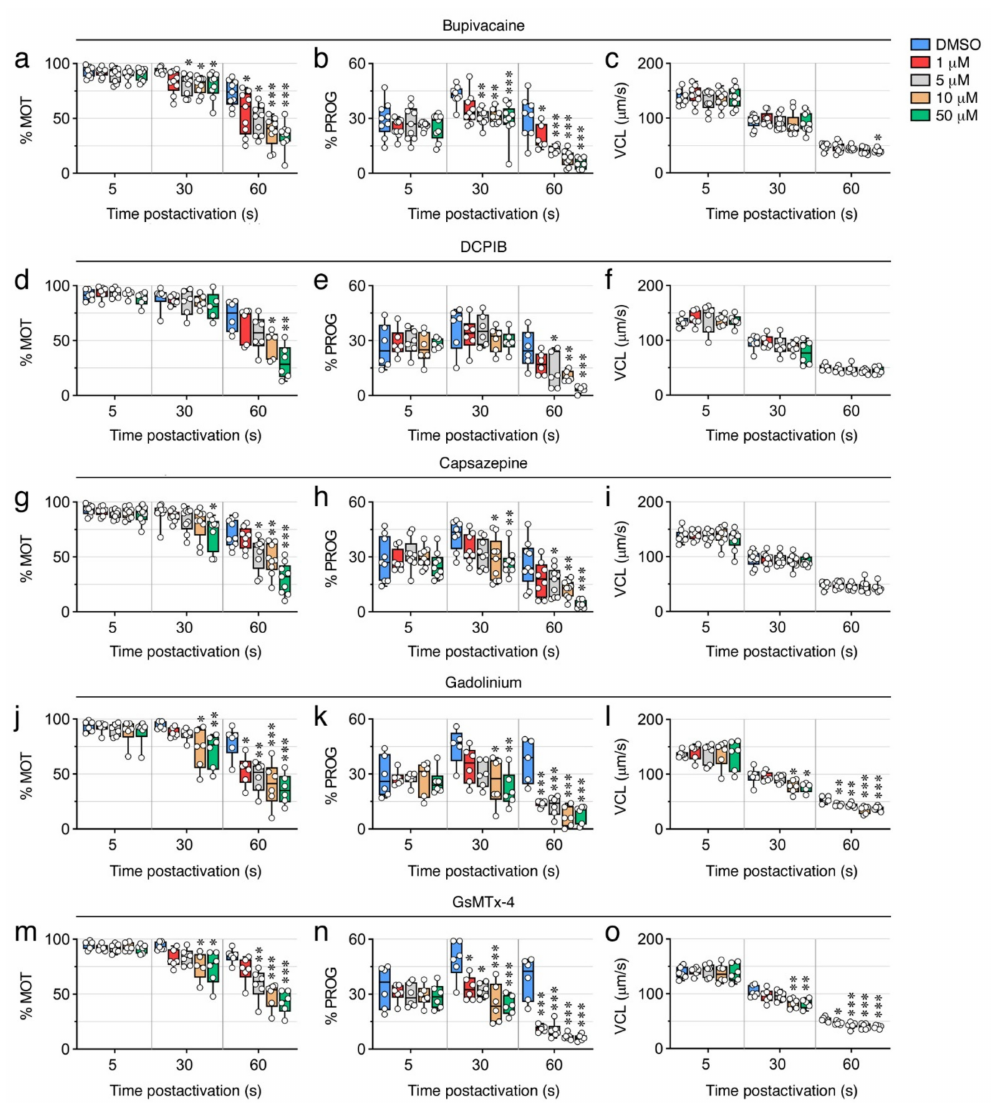
Figure 8. Inhibition of seabream sperm motility by blockers of voltage-gated Na+ channels, VRAC, TRPV, SACs, and MSCs. ( a – o ) Dose-response inhibition of the percentage of motility and progressivity (% MOT and % PROG, respectively) and curvilinear velocity (VCL) at 5, 30 and 60 s post activation induced by the different ion channel blockers as indicated. Control spermatozoa were treated with 0.5% DMSO. In all panels, the data points ( n = 6–8 males, one ejaculated per male) are presented as box and whisker plots/scatter dots with horizontal line (inside box) indicating median and outliers. Statistical differences were measured by one-way ANOVA (*, p < 0.05; **, p < 0.01; ***, p < 0.001, with respect to DMSO-treated